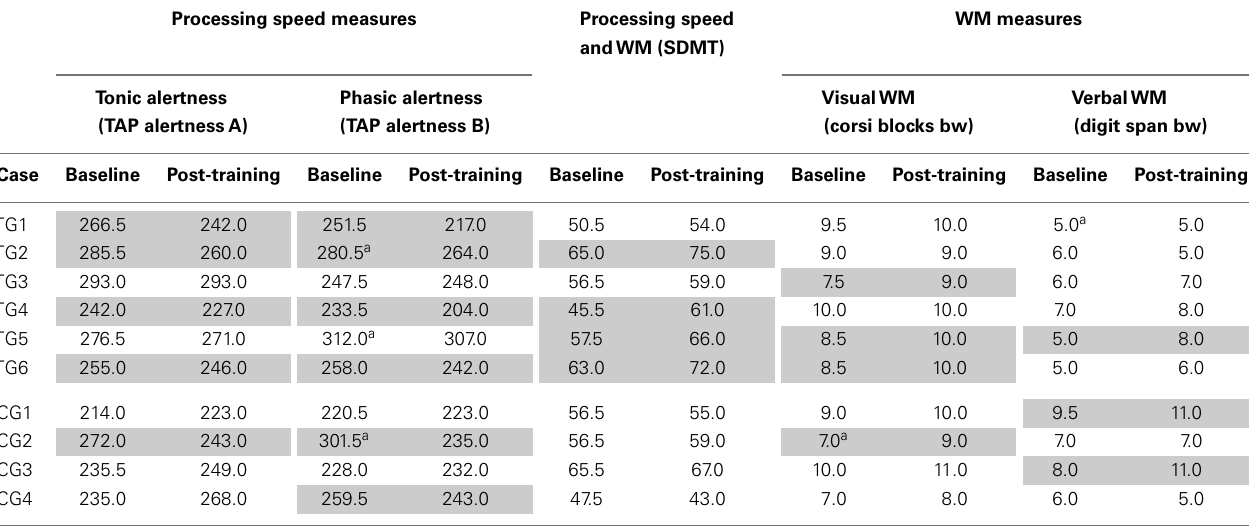
Table 2 | Raw scores of primary cognitive outcome measures for all participants at baseline and after the training . Processing speed